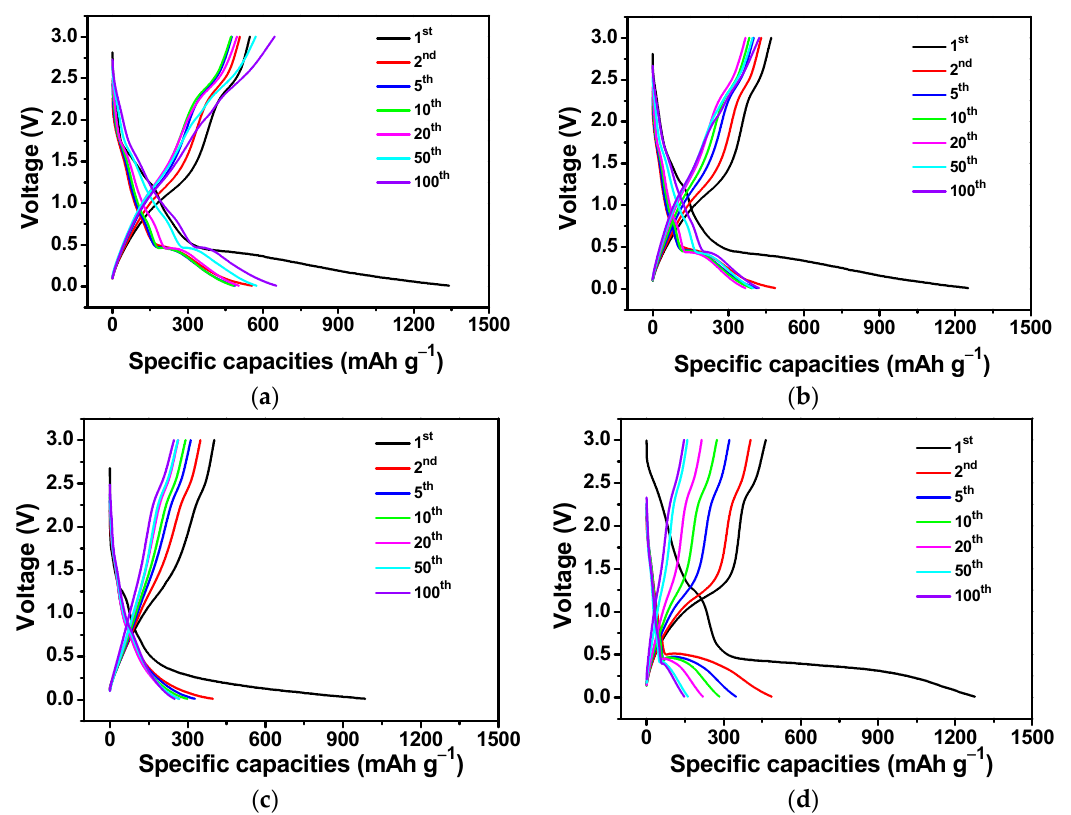
Figure 8. Galvanostatic charge/discharge profiles of ( a ) MnO 2 -TiO 2 -carbon-47.28%, ( b ) MnO 2 -carbon-40.15%, ( c ) TiO 2 -carbon and ( d ) MnO 2 -NPs anode materials measured at a current density of 100 mA g − 1 between 0.01 and 3.0 V.